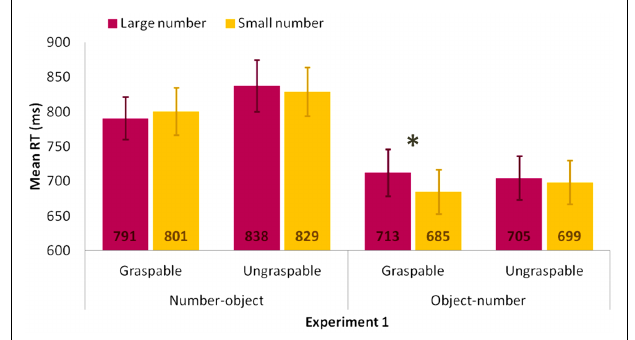
FIGURE 3 | Significant Order × Object type × Numerical magnitude interaction for RTs in Experiment 1, values are in millisecond and bars are SEM. Significant comparisons are indicated with *(p < 0.05) or **(p <